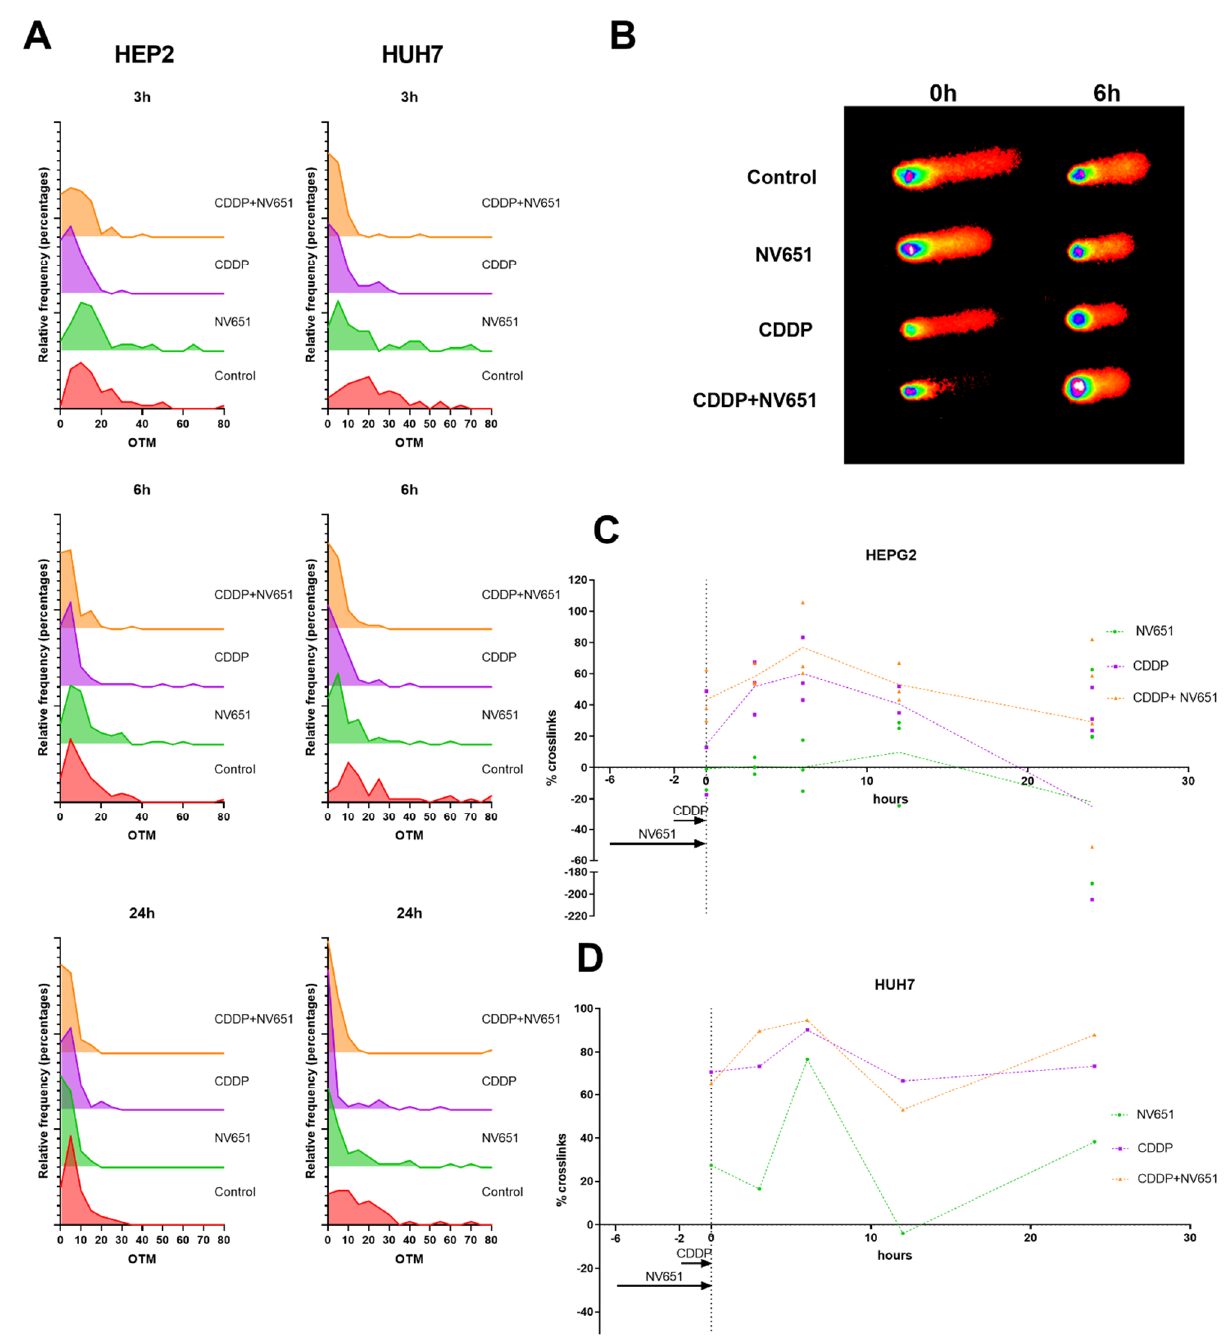
Figure 5. Effect of NV651 and cisplatin on DNA damage for up to 24 h in drug-free media in HEPG2 and HUH7 after 4 h of pre-treatment with NV651 followed by 2 h of cisplatin exposure. Effect on DNA damage was analysed by the alkaline COMET assay. ( A ) Frequency distribution of the olive tail moment at 3, 6 and 24 h. ( B ) Representative comets at 0 and 6 h. ( C , D ) Percent crosslinks calculated in comparison with the control; for each sample a minimum of 50 comets were analysed. n = 3–4 biological replicates in HEPG2 ( C ) and n = 1 biological replicate in HUH7 ( D ). Data in ( C ) are presented as the mean ±